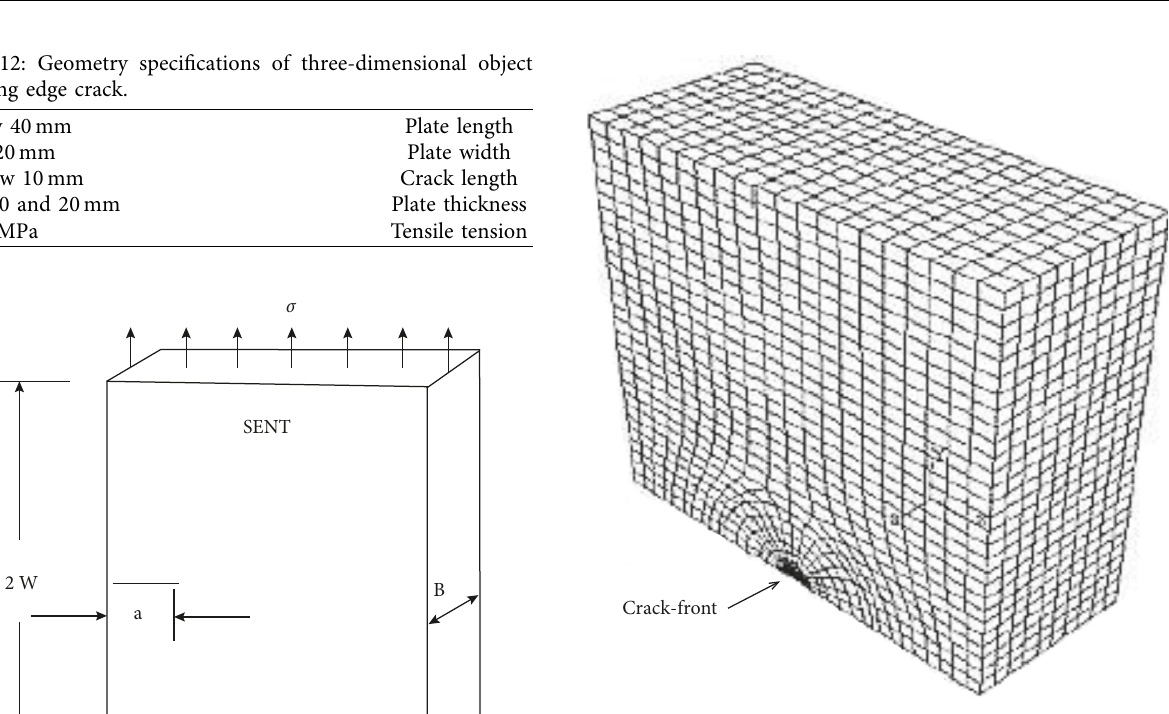
Figure 15: Kind of meshing done [32].